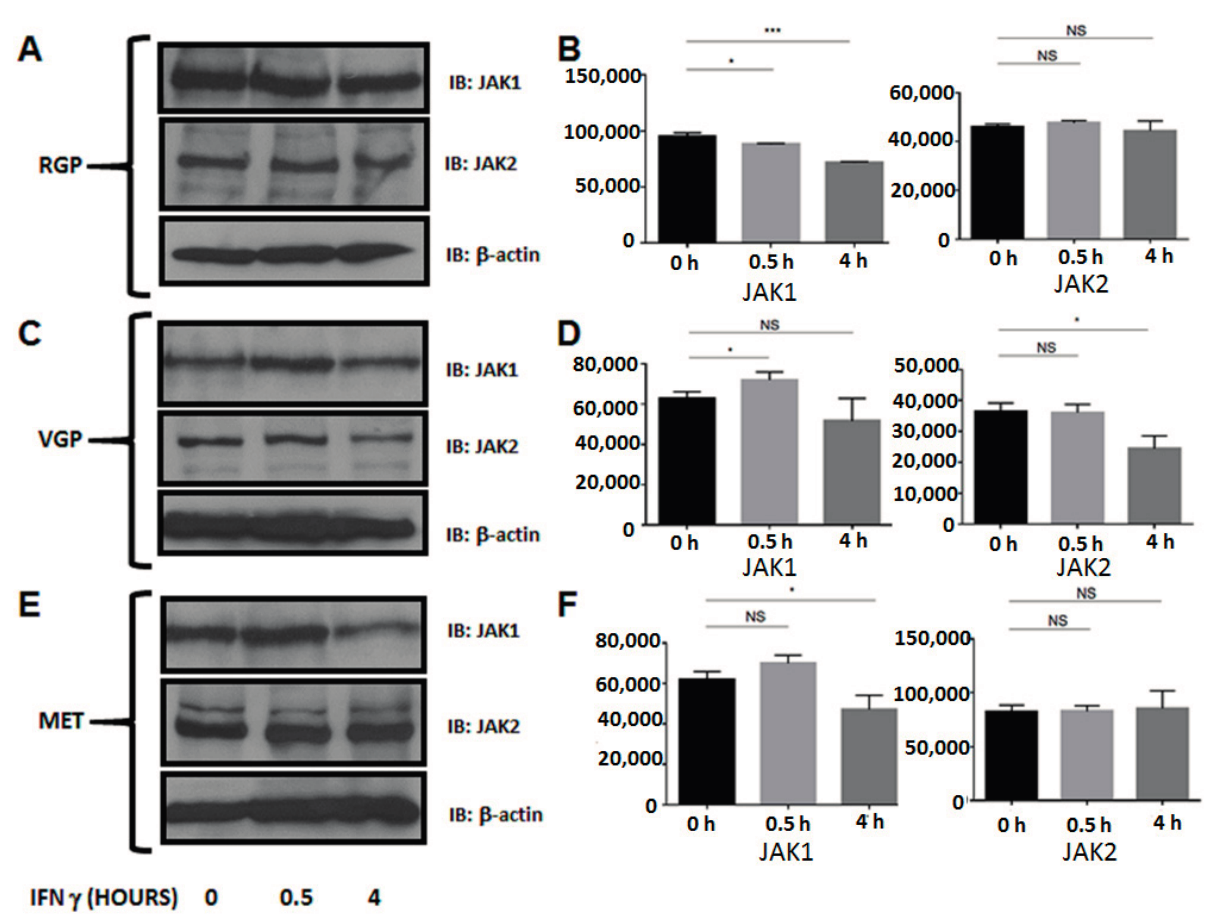
Figure 4. Western blot analysis of JAK1 and JAK2 expression. Cells were stimulated with IFN- γ for 0, 0.5 or 4 h. Lysates were cleared of cellular debris, and equal concentrations of protein were separated via SDS-PAGE. Proteins were identified by incubating nitrocellulose with antibodies against JAK1 (RGP, VGP, MET; top ) or JAK2 (RGP, VGP, MET; middle ). β -Actin was used as a loading control (RGP, VGP, MET; bottom ). ( A – F ) JAK1 and JAK2 are constitutively expressed in RGP, VGP and MET cells. The data shown are representative of a minimum of three experimental replicates. The y -axis represents Pixel Total (quantification of A, C, E). NS: Not Significant; * p < 0.05, *** p <